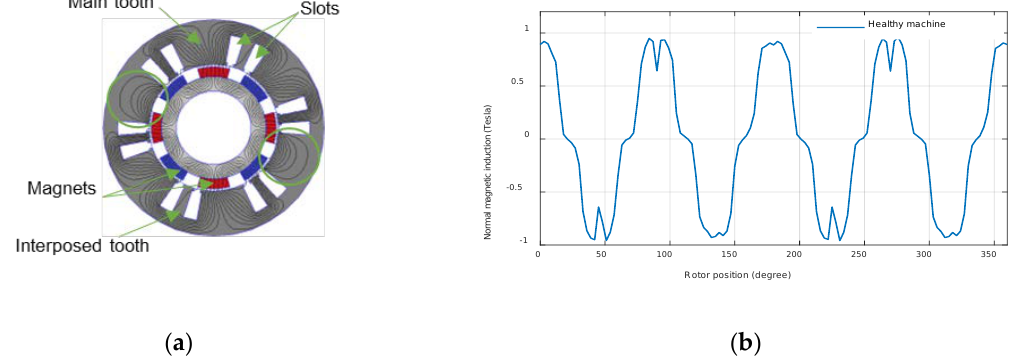
Figure 5. Healthy case: ( a ) Magnetic field of the healthy PMSM; ( b ) airgap magnetic flux density.